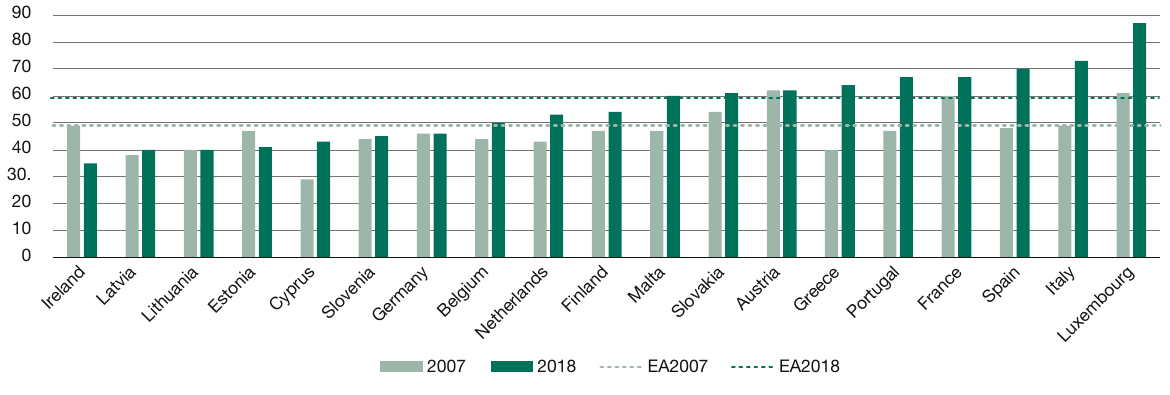
Development of the funded pillar in Italy